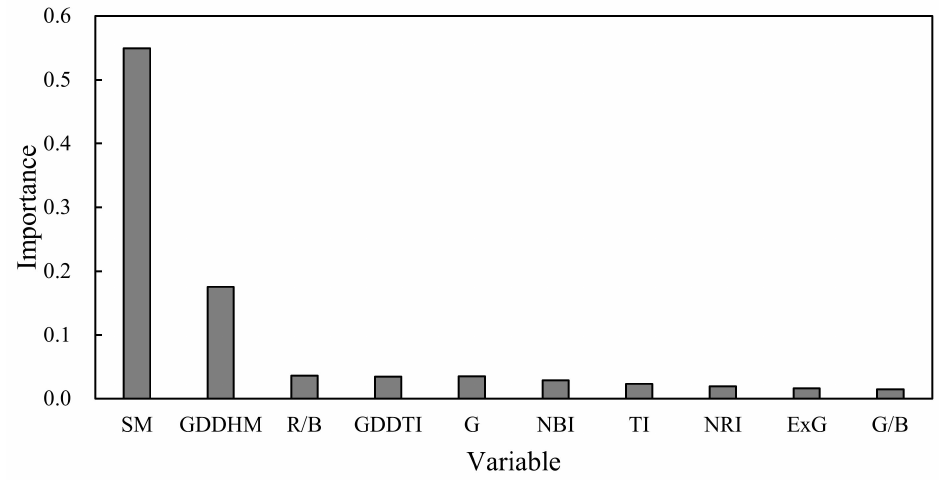
Figure 9. Ranking of the top 10 important variables in the RF (VIs + phenology)